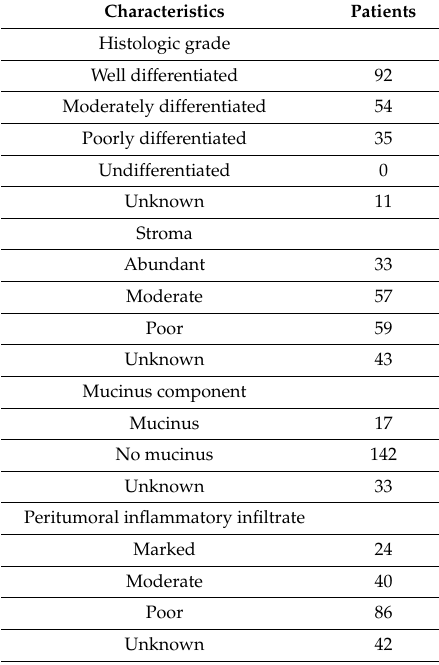
Table 4. Histopathological data for the biopsies used in the miRNA validations. Data regarding histological grade, stroma abundance, mucinous component, peritumoral inflammatory infiltrate are